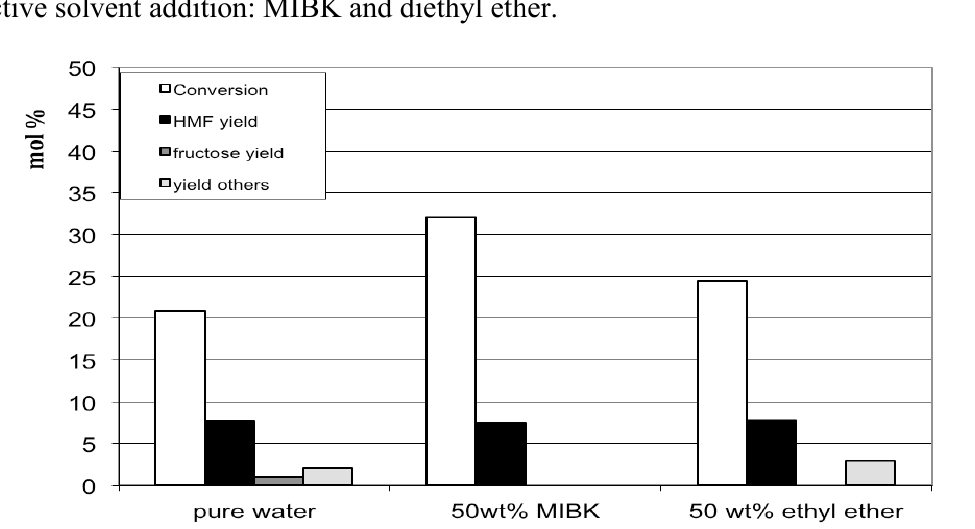
Figure 10. Glucose conversion in water at 150 °C in the presence of NbOH: influence of extractive solvent addition: MIBK and diethyl